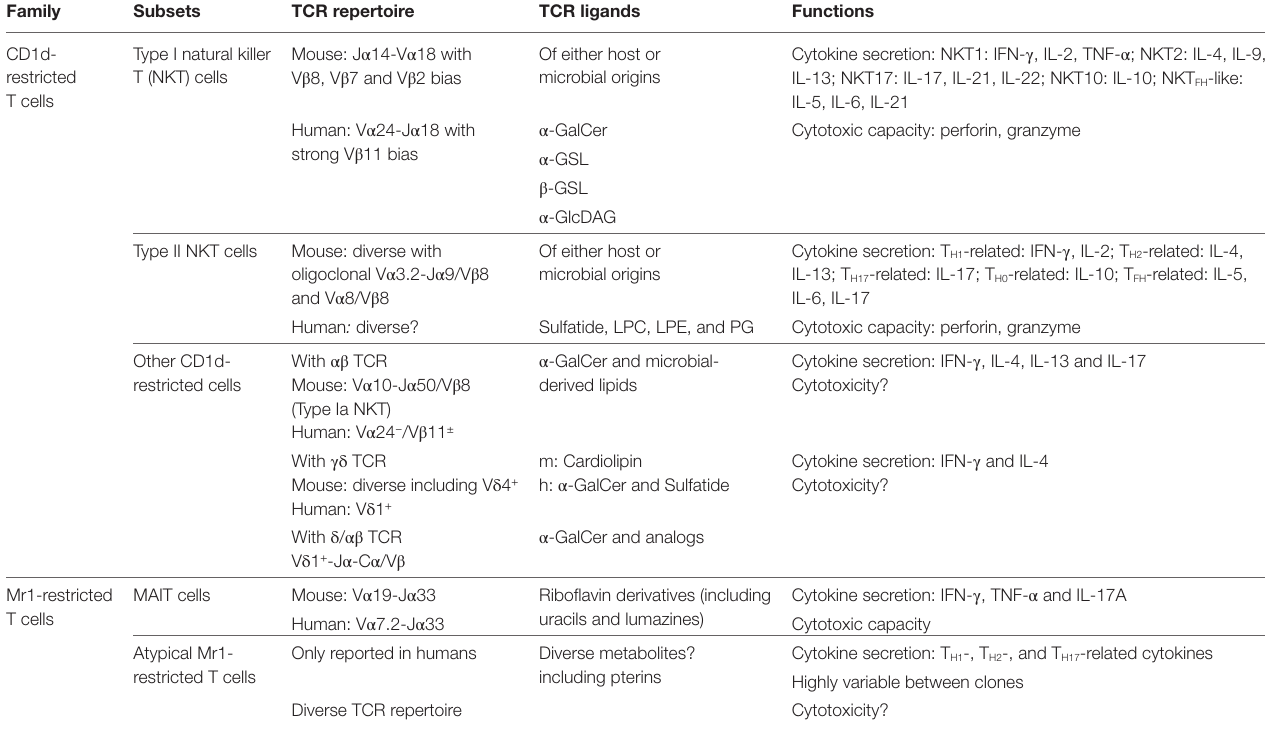
TAbLe 1 | Classification and characteristics of CD1d- and MR1-restricted T